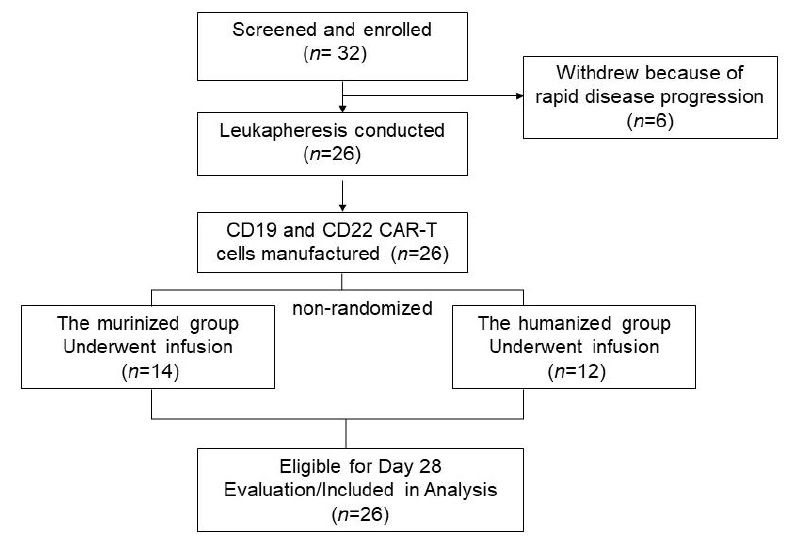
Figure 1. Consort diagram of patient flow. 32 patients were enrolled in the study, 6 patients withdrew because of disease progression, and 26 patients successfully underwent leukapheresis and CD19/22 cocktail CAR-T cell infusion. All 26 patients were available for day 28 evaluation post CAR-T cells infusion. CAR-T: chimeric antigen receptor-T cell. Table 1. Patients’ baseline